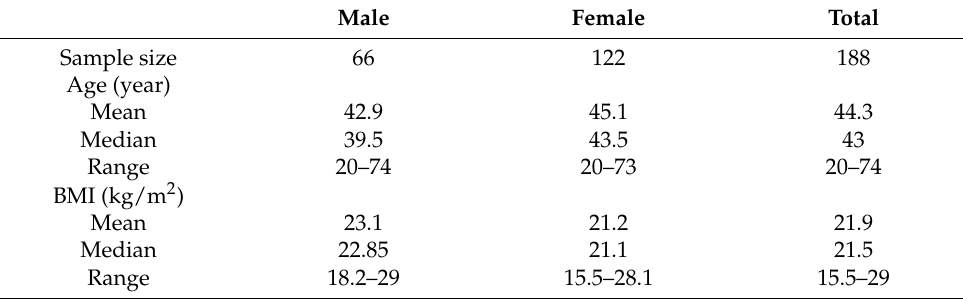
Table 1. Demographic data of 188 healthy subjects.